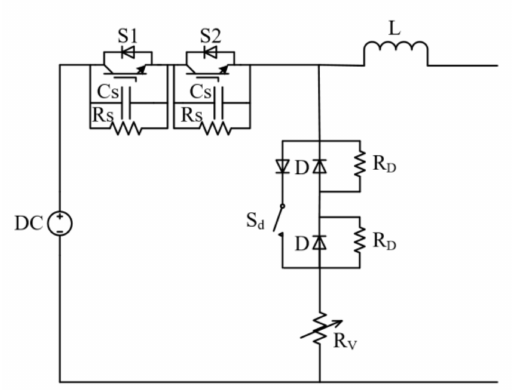
Figure 10. Solid-state DC CB with freewheeling